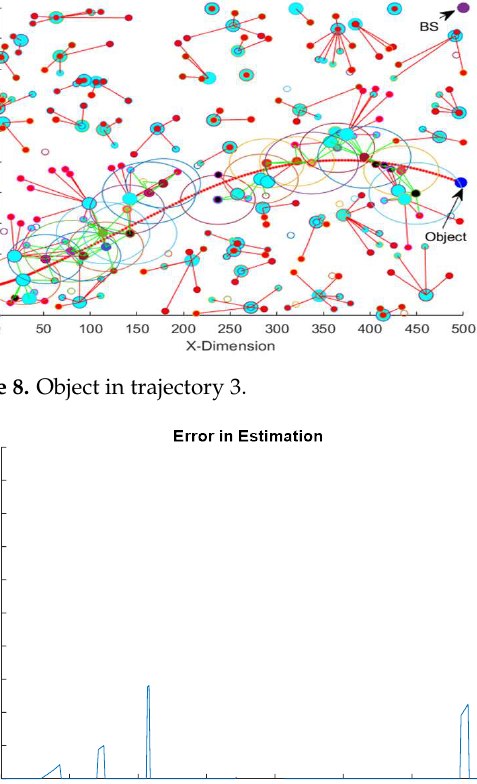
Figure 8. Object in trajectory 3. Figure 7. Object in trajectory 2. Figure 7. Object in trajectory 2. Table 13. Energy consumption, average detection error and average object localization error.